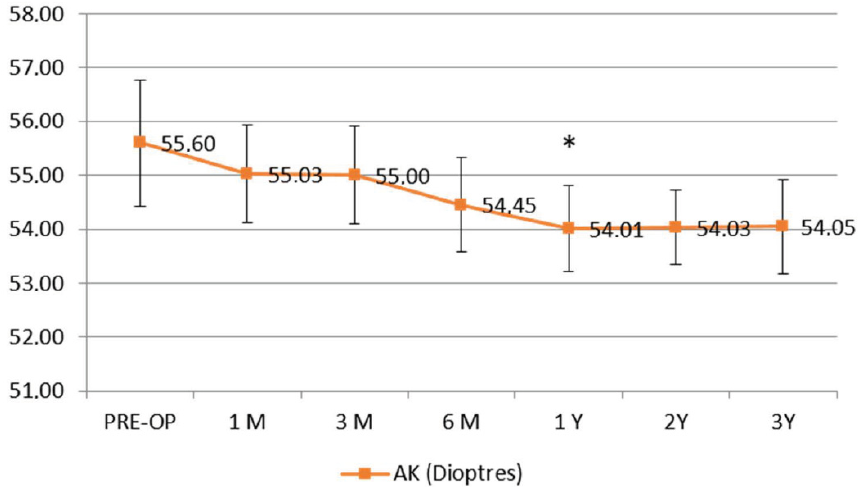
Figure 2. Apical curvature (AK). Topographic apical curvature (AK) showed a statistically significant decrease at 1 year follow-up ( ∆ − 1.59 ± 08 diopters), reaching a stabilization. The maximum simulated keratometry value (K Max) improved along the follow up since the third month, becoming statistically significant at 1 year ( ∆ of − 1.3 D ± 0.78 D) from the baseline value (Figure 3).